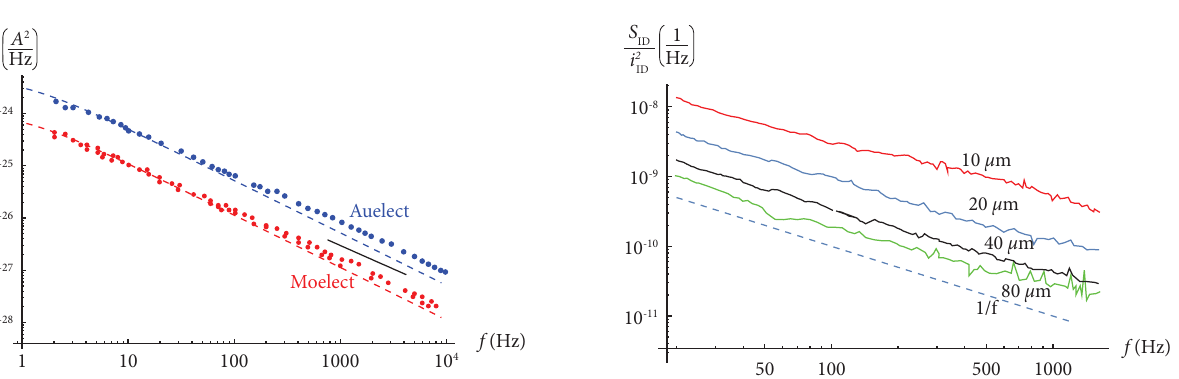
Figure 1: Room temperature data for GeTe [29] compared with Figure 2: Normalized drain-current noise spectral densities � 10 − 6 s , σ � 2 . 5s and τ � equation (2) (blue and red lines): σ ( S ID / I 2 ID ) for four channel thicknesses of amorphous indium- 1 2 1 � 2 . 5 s . A 1/ f 0 . 9 line in black is shown at the bottom right 10 − 6 s , τ gallium-zinc-oxygen thin flm transistors [24]. Dashed line at 2 of the graph for comparison. bottom represents a 1/ f line.